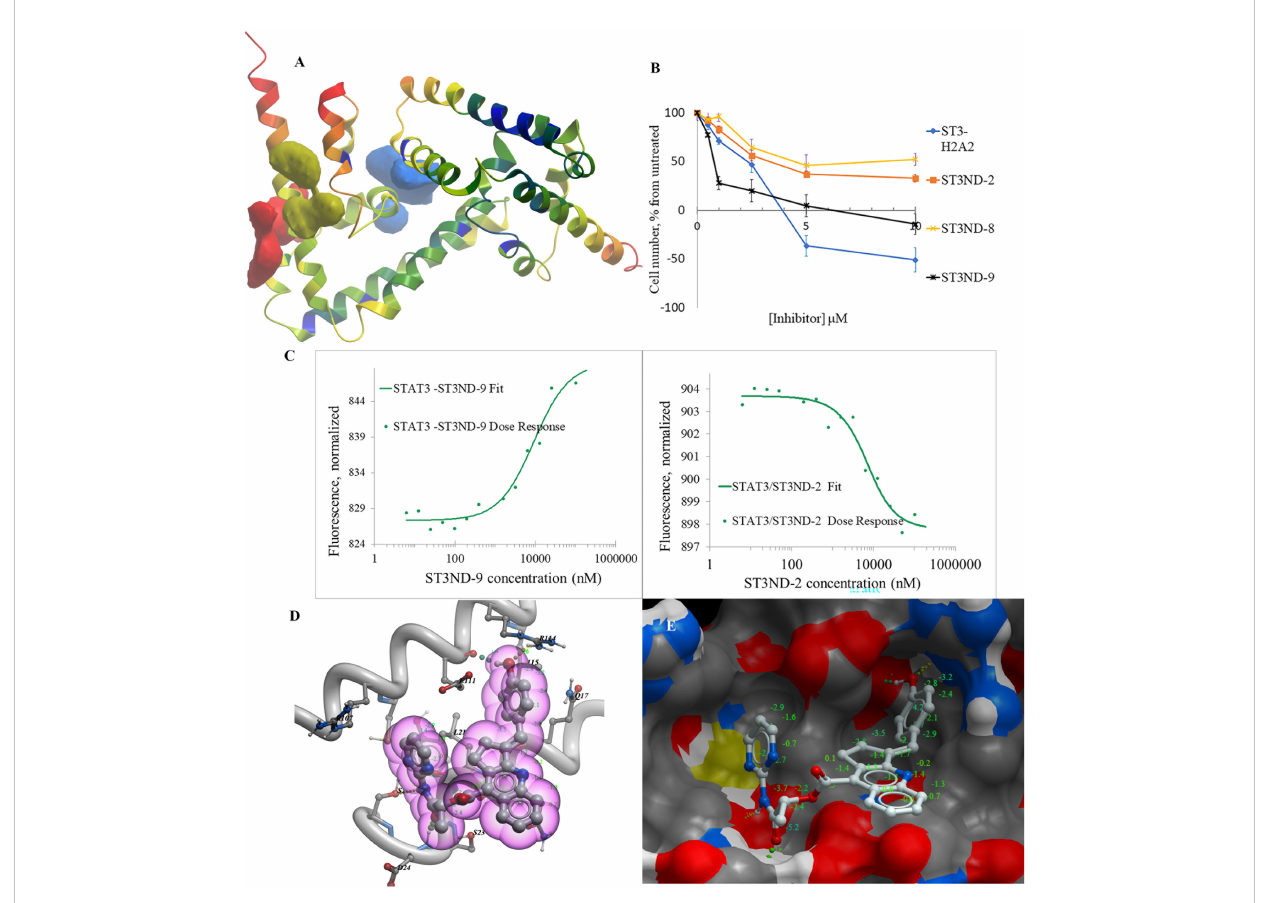
FIGURE 1 Structure-based development of STAT3 N-domain inhibitors: (A) , Structure of STAT3 N-domain dimer (PDB 4ZIA). The best binding pocket is in green. The next most druggable binding pockets are shown in blue and red, respectively. Protein ribbon is colored by B-factor with red representing the most mobile parts, and blue corresponding to the best-resolved ones. All pockets reside in mobile areas of the structure; (B) , An example of STAT3 N-domain inhibitors effects on the growth of prostate cancer DU145 cells. Cells have been exposed to compounds for 48 hours and the number of surviving cells was quantitated using MTT assay. N-terminal domain peptide inhibitor ST3H2-A2 (12) was used as a positive control; (C) The examples of Microscale Thermophoresis (MST) binding assays- titration of hit compound, ST3ND-9, into recombinant STAT3 N-terminal domain. His-tagged STAT3 N-domain was labeled with non-covalent fl uorescent dye RED-tris-NTA for detection by MST. The protein concentration was 50 nM. Apparent K d =7.3 m M; (D) , STND-9 compound docked into STAT3 N-terminal domain structure. Phenol group of the hit fi ts well in